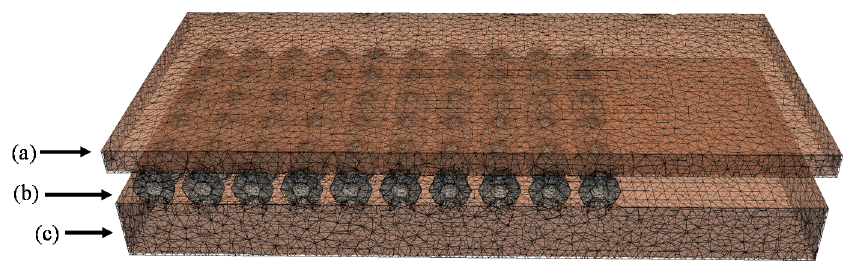
Figure 5. A cross section view of the geometric model and mesh used in the Monte Carlo simulation of light propagation through the OSA ( b ) with a 3- or 5-mm phantom above ( a ). The OSA was placed on a 15-mm phantom ( c ). There were as many as 1.8 × 10 6 elements in the mesh of the entire geometry.